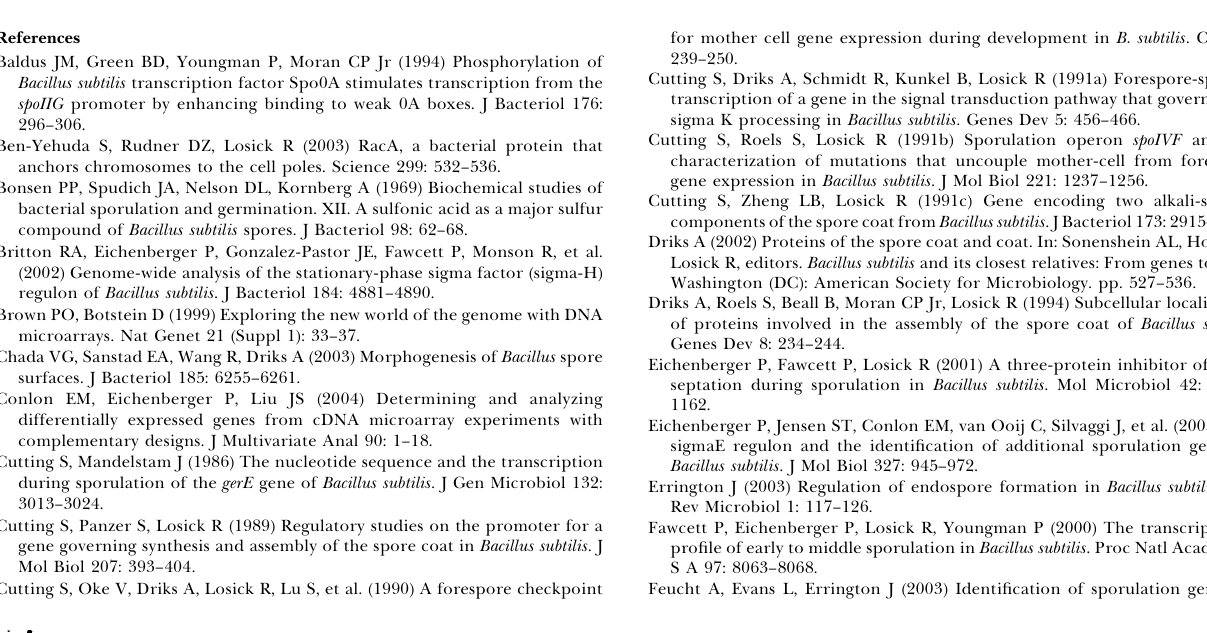
Table S1. Mother-Cell Gene Expression Table S2. Effect of SpoIIID and GerR on the expression of genes in the r E regulon. Found at DOI: 10.1371/journal.pbio.0020328.st002 (351 KB XLS). Table S3. ChIP-on-chip data for SpoIIID. Table S4. Effect of GerE on the expression of genes in the r K